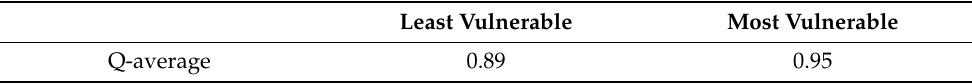
Table 13. Q-average of least and most vulnerable zones to earthquakes in Tabriz, Iran. Least Vulnerable